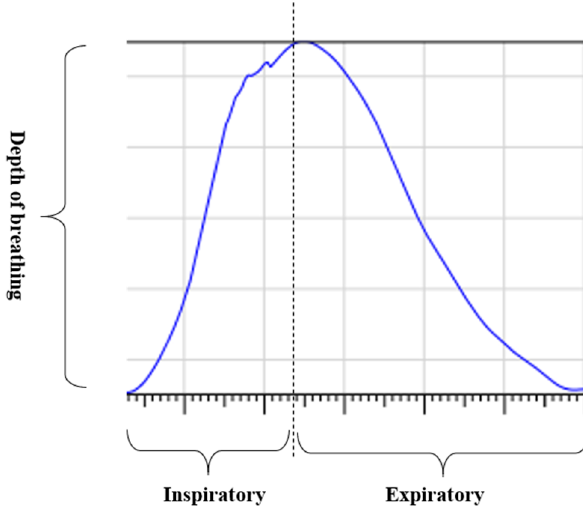
Figure 2. Signal occurred by inspiratory, expiratory, and depth of breathing during breathing.